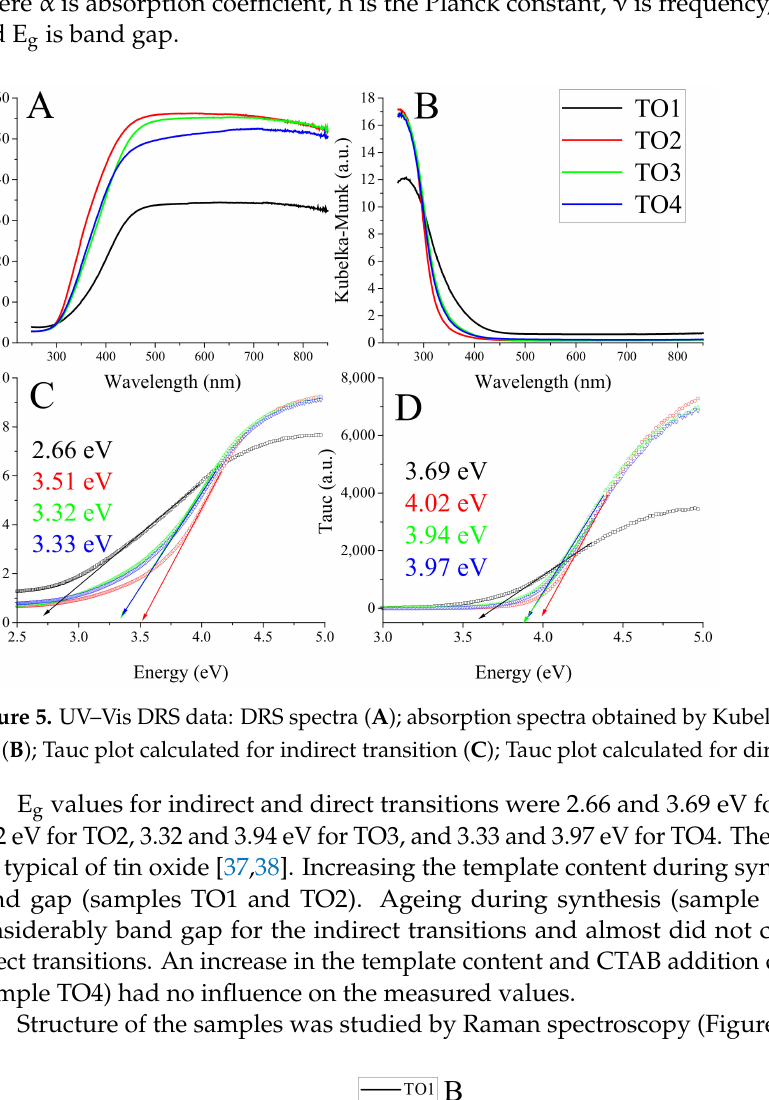
(sample TO4) had no influence on the measured values.